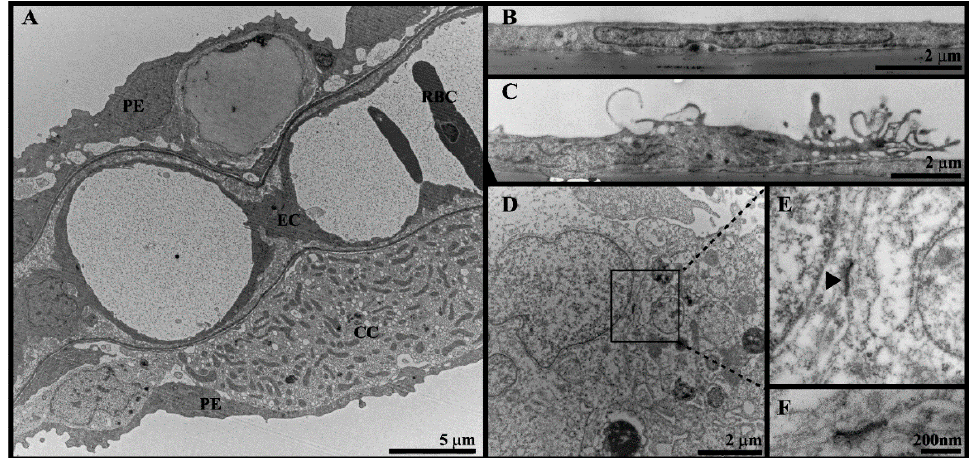
Figure 6. Ultrastructure of whole lumpfish gill ( A ) and LG-1 cells ( B – F ). ( A ) TEM of gill showed pavement epithelial cells (PE), pillar endothelial cells (EC), red blood cells (RBC) and chloride cells (CC). ( B – F ) TEM of LG-1 cells showed ( B ) elongated shape, ( C ) surface protrusions and ( D – F ) structures compatible with desmosomes.